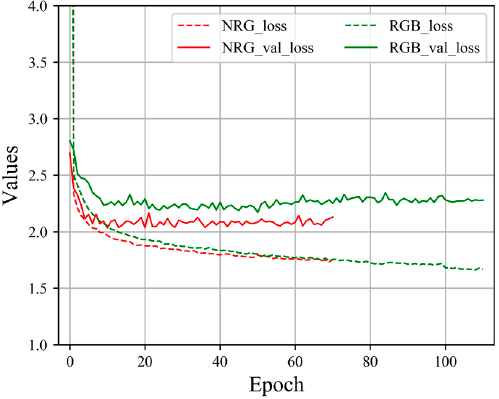
Figure 10. Loss curve for different band combinations.